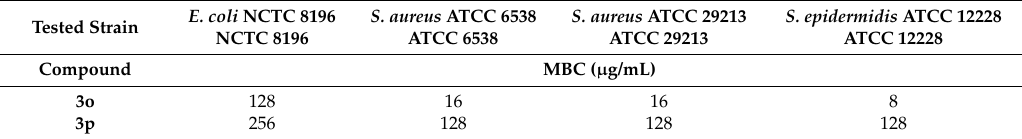
Table 7. In vitro antibacterial activity of 3o and 3p expressed as a minimal bactericidal concentration (MBC) ( µ g/mL). Tested Strain